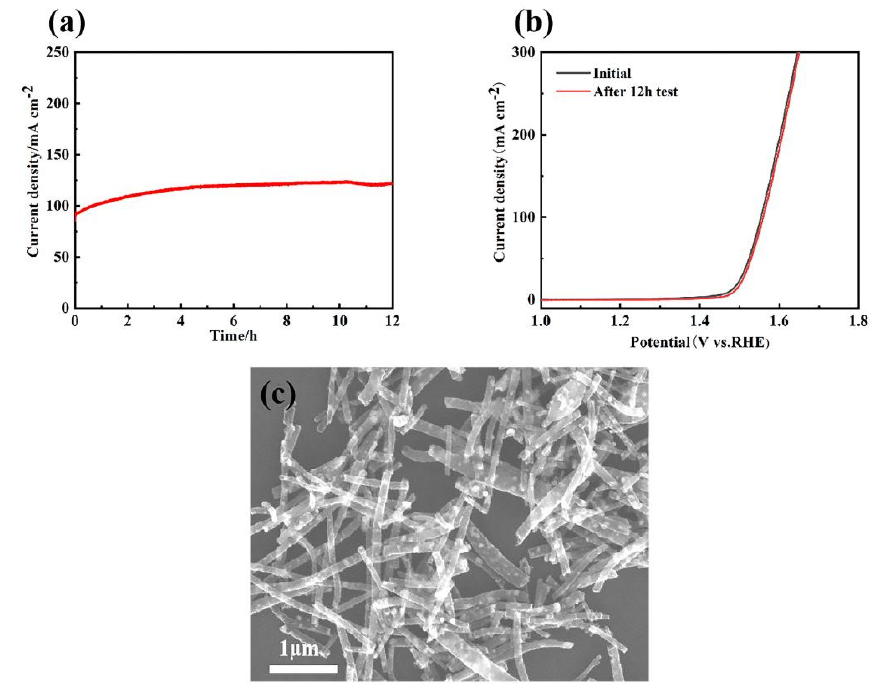
Figure 7. ( a ) LSV image after stability test; ( b ) i-t image; ( c ) SEM image after stability